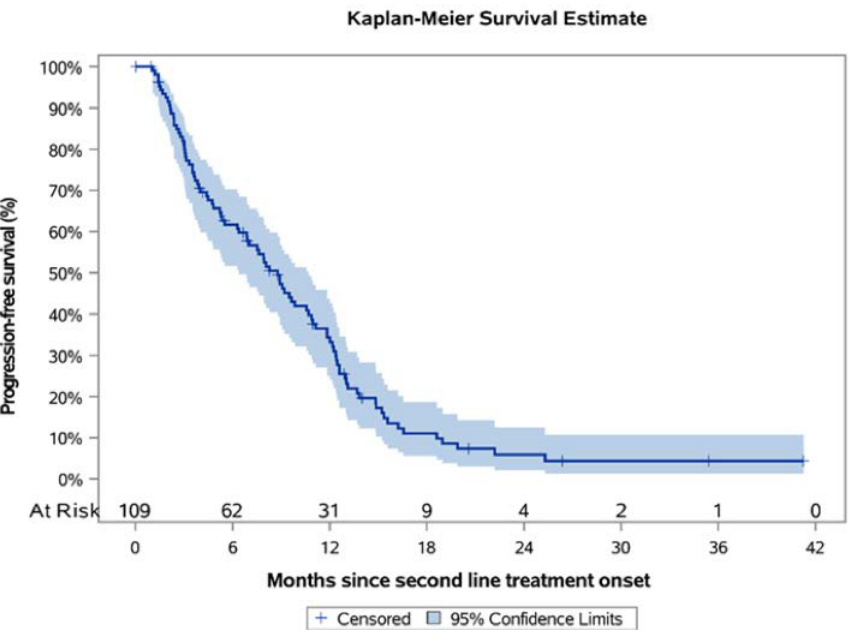
Figure 4. Kaplan-Meier progression-free survival curve in the second-line treatment setting.